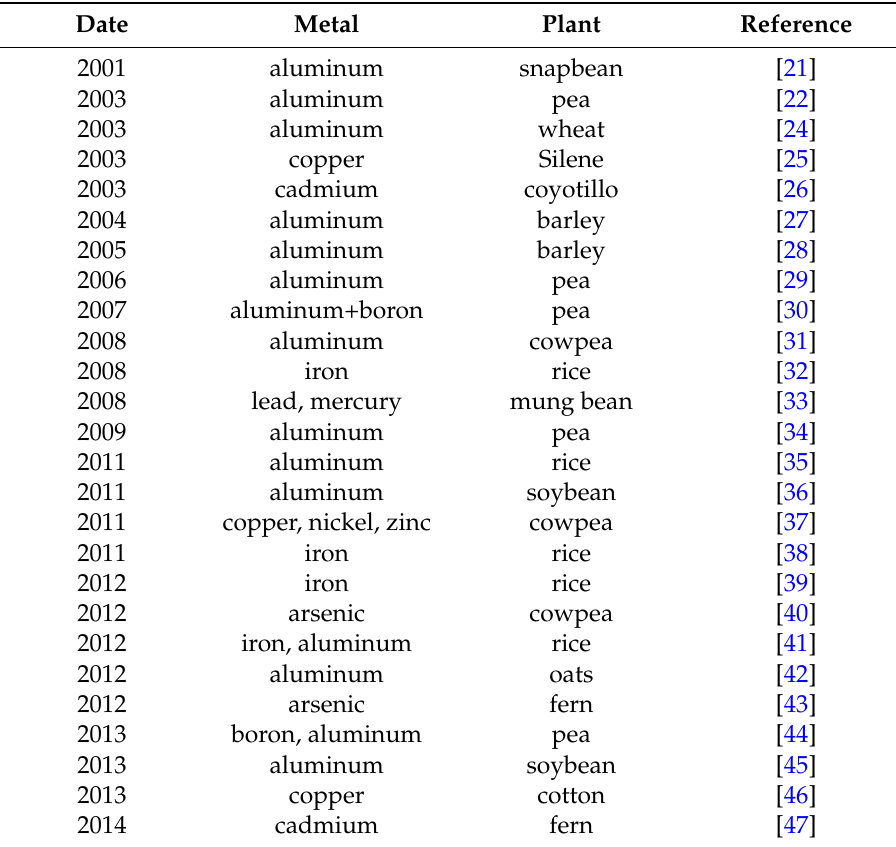
Table 1. Border cells and metals: publications from 2001–2015. Metal Plant